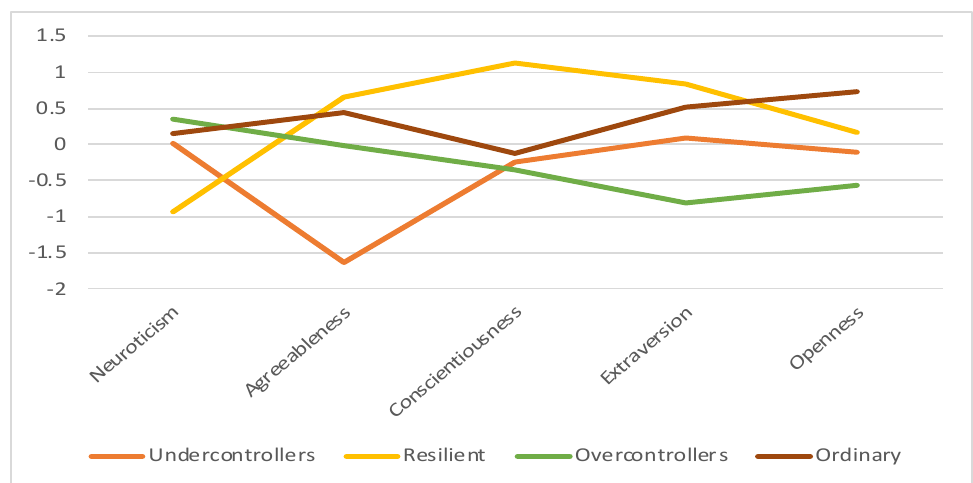
Figure 1. Profile plot for Five Factors in FFM-Only Profiles. Note. Standardized mean scores (M = 0, Figure 1. Pro fi le plot for Five Factors in FFM-Only Pro fi les. Note . Standardized mean scores (M = 0, SD = 1) of the Five-Factor Model of Personality across four SD = 1) of the Five-Factor Model of Personality across four pro fi les.